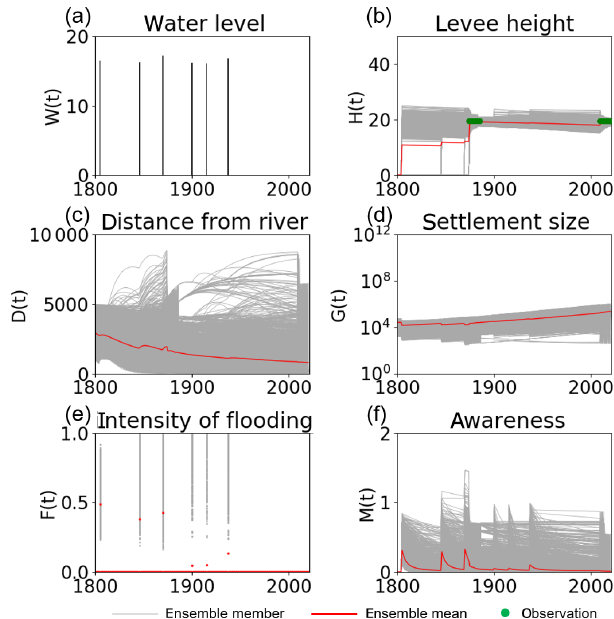
Figure 15. Same as Fig. 13 but only real data of H are